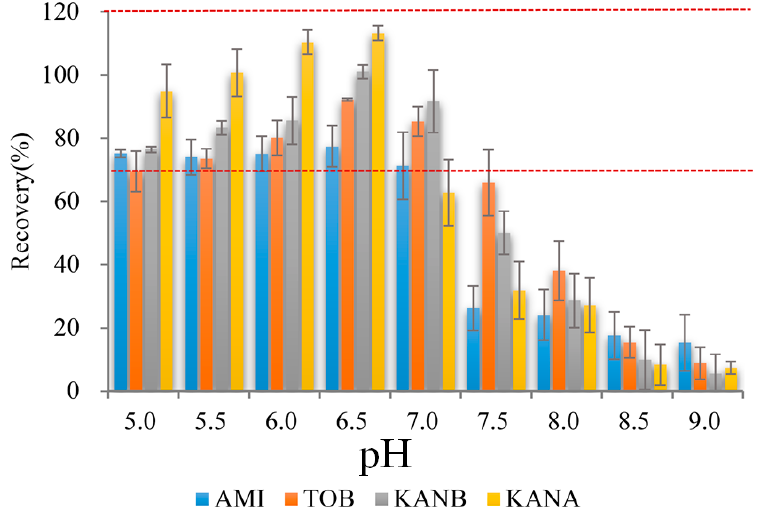
Figure 3. Effect on analytes recoveries of binding buffer pH ( n = 3) (Red dash lines reprensents the recoveries form 70% to 120%).